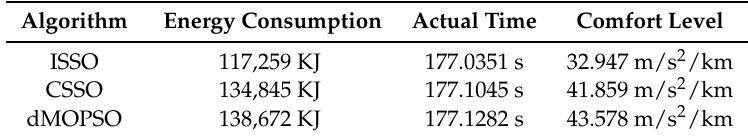
Table 12. The HILS tracking control results of different algorithms for Jinpu line No.1 in Dalian scenario.